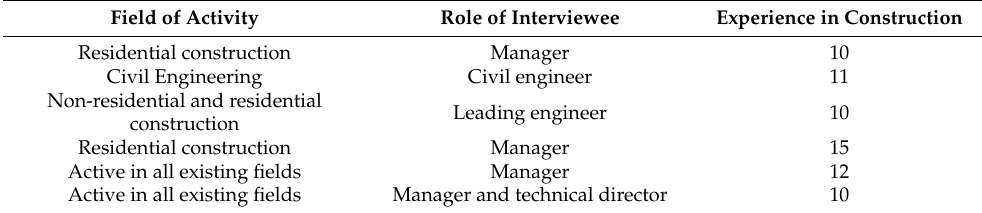
Table 1. Profile of